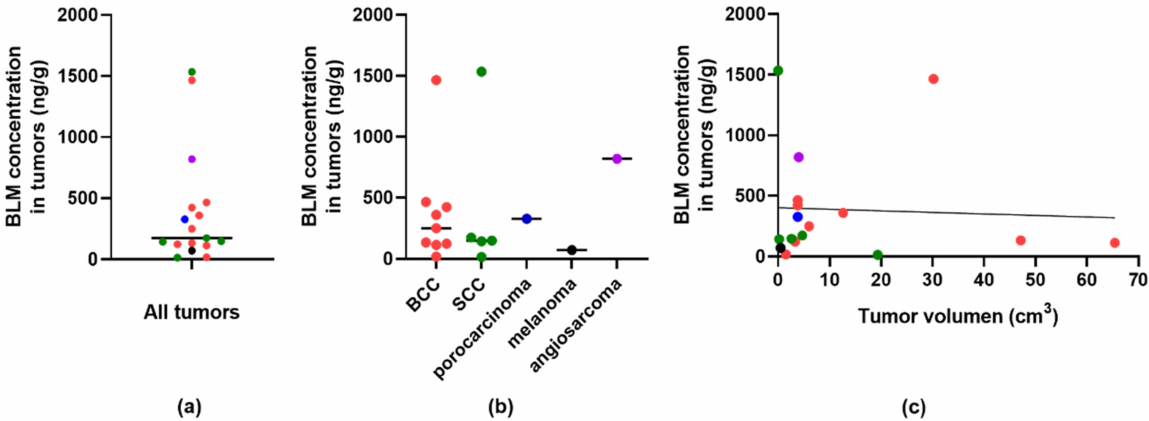
Figure 2. Median bleomycin concentrations in tumor samples. ( a ) Bleomycin (BLM) concentrations normalized to 1 g of the tumor sample in all analyzed tumors. ( b ) Bleomycin (BLM) concentrations normalized to 1 g of the tumor sample in correlation to tumor type. ( c ) Correlation of bleomycin (BLM) concentrations in tumor and tumor volume with linear curve fit